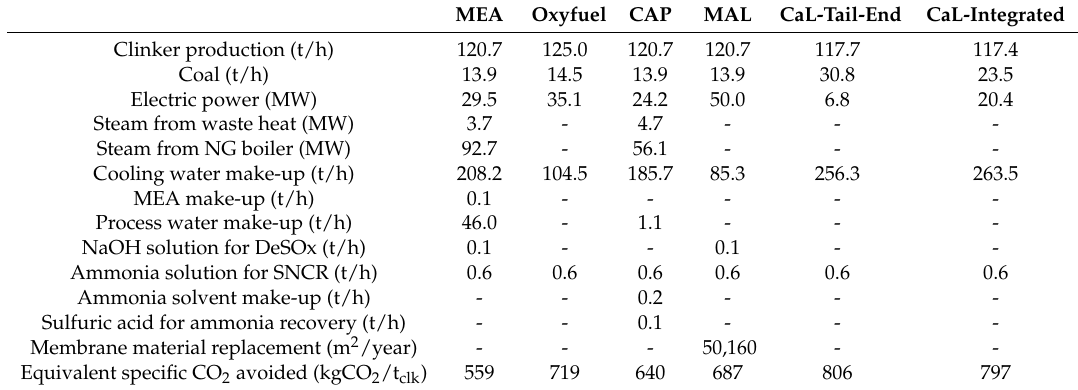
Table 2. Utilities, consumables and CO 2 avoided for the cement plant with CO 2